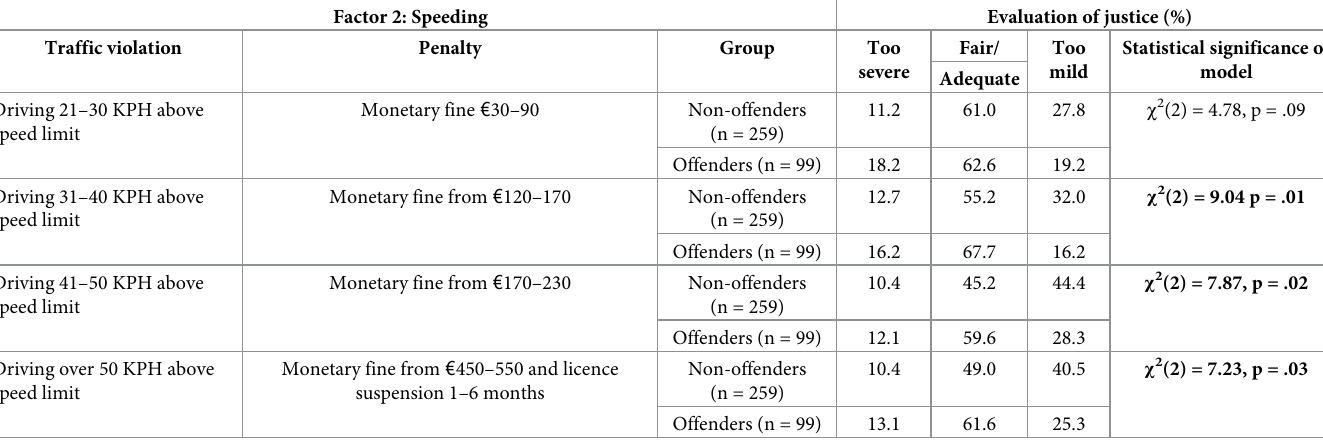
Table 6. The perceived justice of the penalties for the types of speeding offences (offenders vs. non-offenders). Factor 2: Speeding Evaluation of justice (%) Traffic violation Penalty Group Too